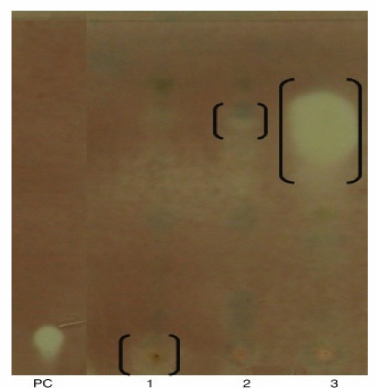
Figure 4. TLC qualitative AChEI assay. PC: + ve control, physostigmine (0.03 µ g). DCM / MeOH extracts (100 µ g) of (1) Hypnea musciformis , (2) Pterocladia capillacea , and (3) Ochtodes secundiramea . TLC elution system: hexane:ethyl acetate:methanol (2:7:1 v / v / v )